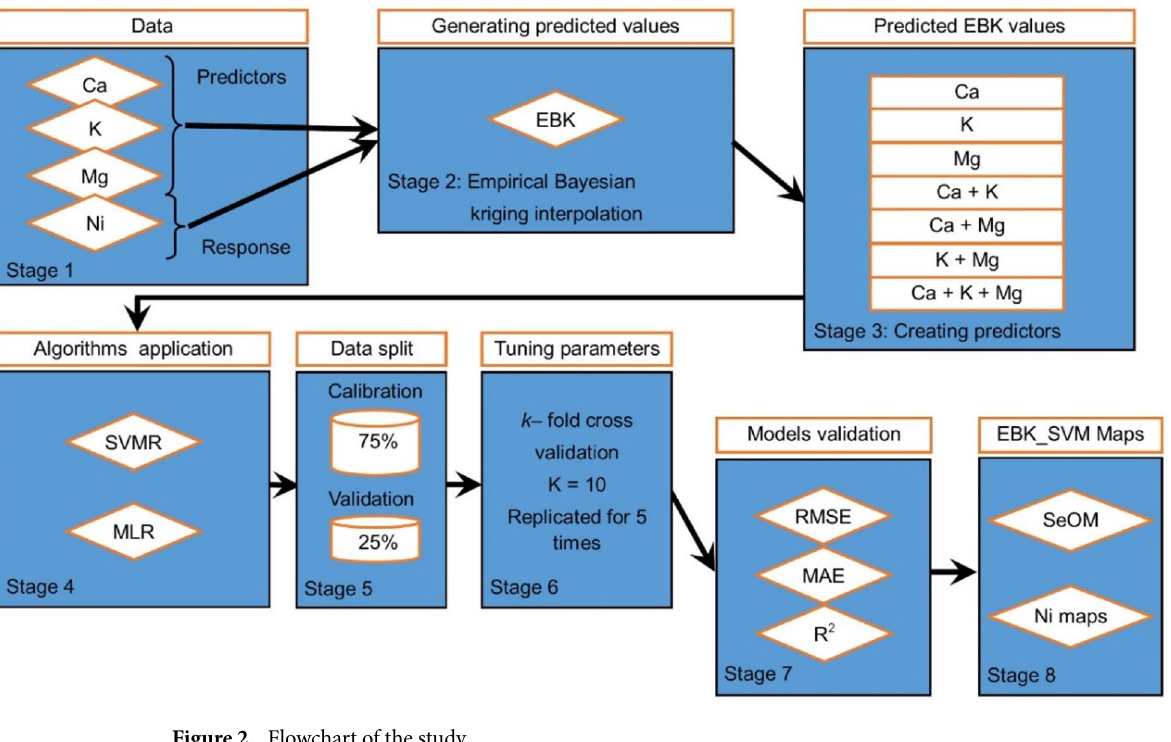
Figure 2. Flowchart of the